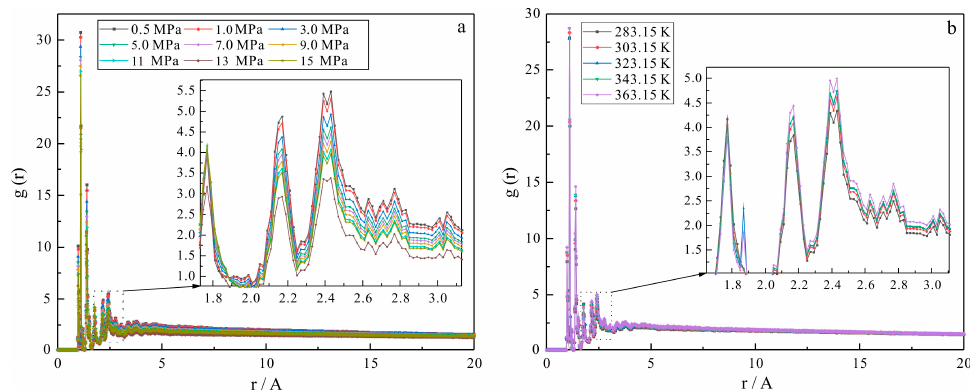
Figure 16. ( a ) Radial distribution function between methane molecules and C atoms, calculated from molecular dynamics simulations, as function of truncation radius for different pressures; ( b ) and temperatures.